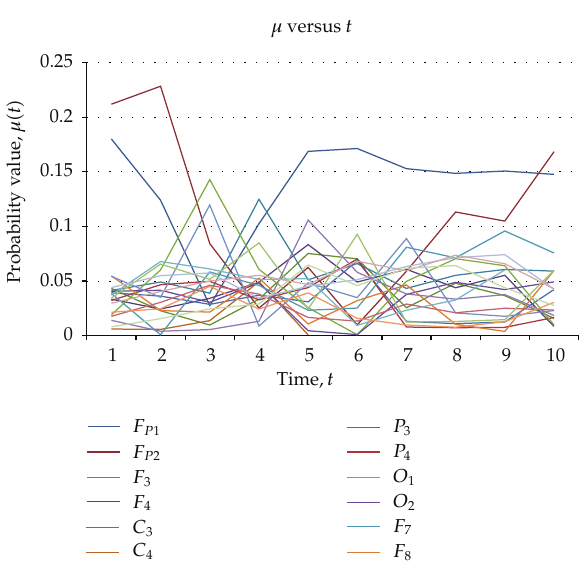
Figure 5: Plot of measure values over time for a 10-second seizure observed in Patient A.